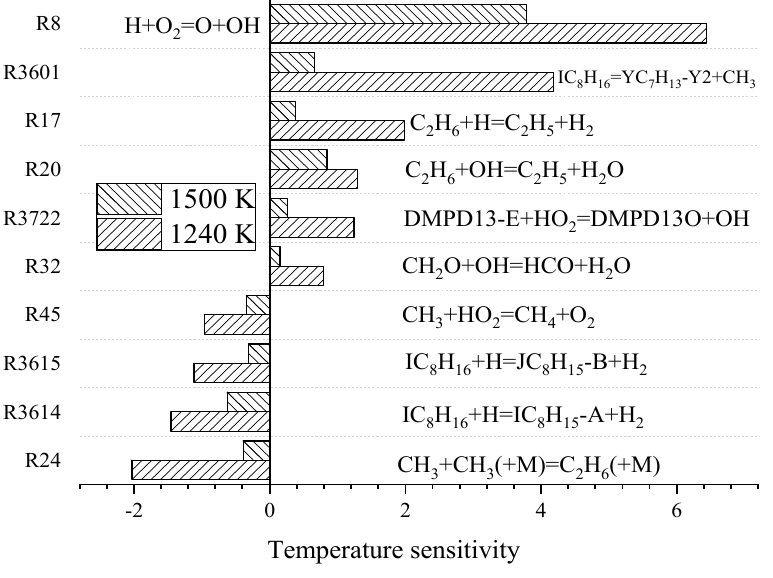
(b) NCO Figure 8. Main reaction rate of HCN ( a ) and NCO ( b ). Figure 9a shows the reaction rate of H 2 CNO 2 . The reaction R4446 (CH 3 NO 2 + OH = H 2 CNO 2 + H 2 O) had the highest rate of formation, and CH 3 NO 2 and OH reacted to dehydrogenate to form H 2 CNO 2 . The reaction R4457 (H 2 CNO 2 = CH 2 O + NO) had the largest rate of consumption, and H 2 CNO 2 was decomposed into CH 2 O and NO. Figure 9b shows the reaction rate of CH 3 NO 2 . The reaction R4439 (CH 3 NO 2 [+M] = CH 3 + NO 2 [+M]) had the highest reaction rate. CH 3 and NO 2